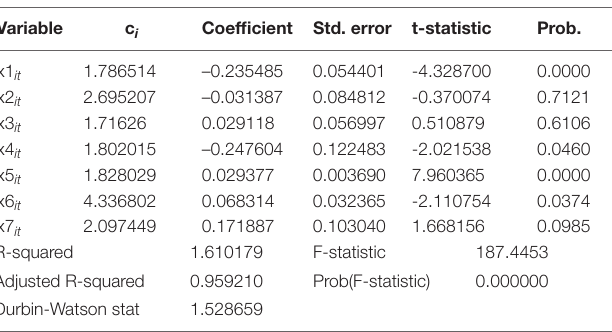
TABLE 8 | Regression results of panel